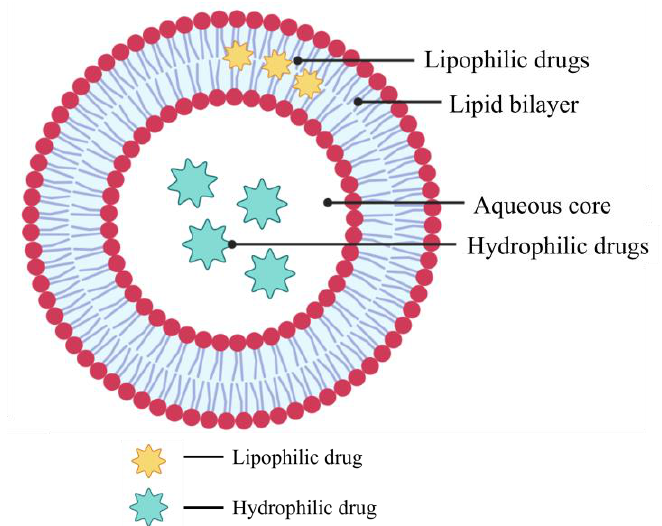
Figure 4. The structure of a liposome encapsulating